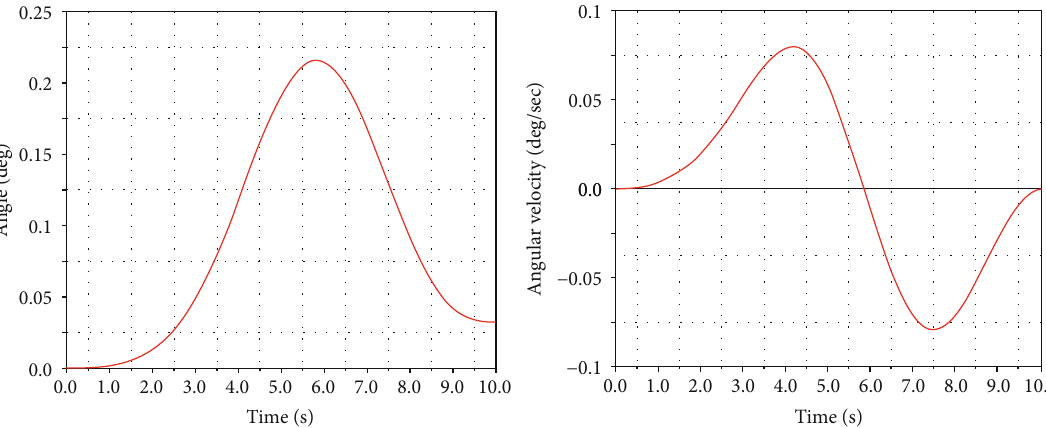
Figure 7: Optimized trajectory of the base for the planning case of zero attitude disturbance.